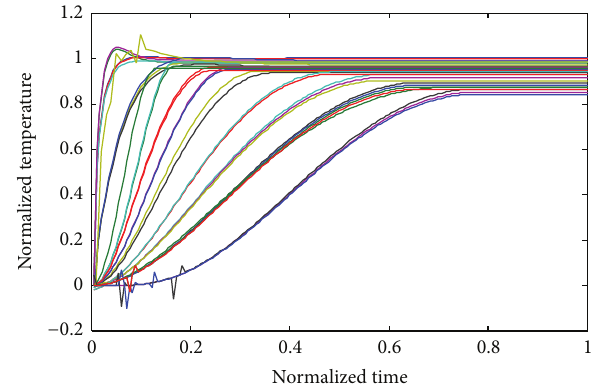
Figure 2: Normalized temperature response spectrum along the center of the slab in the case of 𝑍 𝑇 = 0.5 .